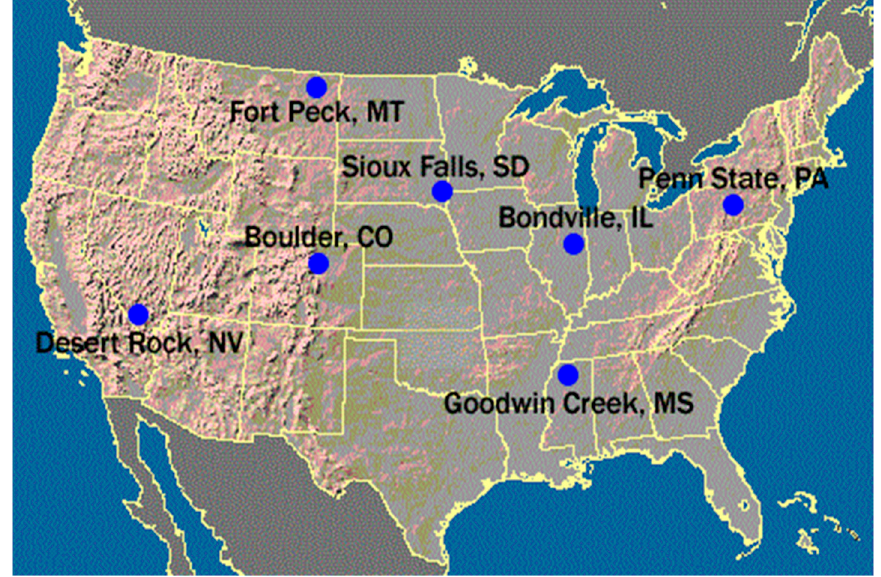
Figure 1. Map of the seven SURFRAD sites (courtesy of the NOAA). Table 1. Description of the ground-based stations used for the measurement collection, from the northernmost station to the southernmost